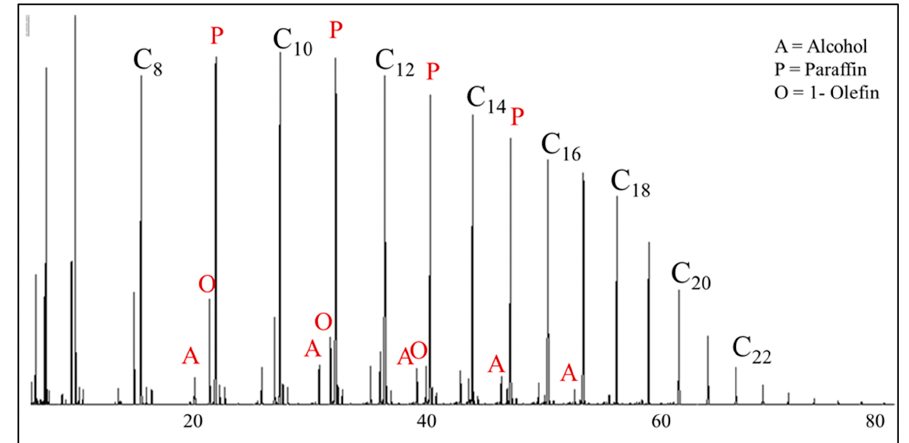
Figure 15. A chromatographic picture of the oil for the alumina supported ruthenium catalyst. The x-axis is retention time in minutes. Reaction Conditions: 241 °C, 19.2 bar, WHSV = 1.5, and H 2 /CO = 2.